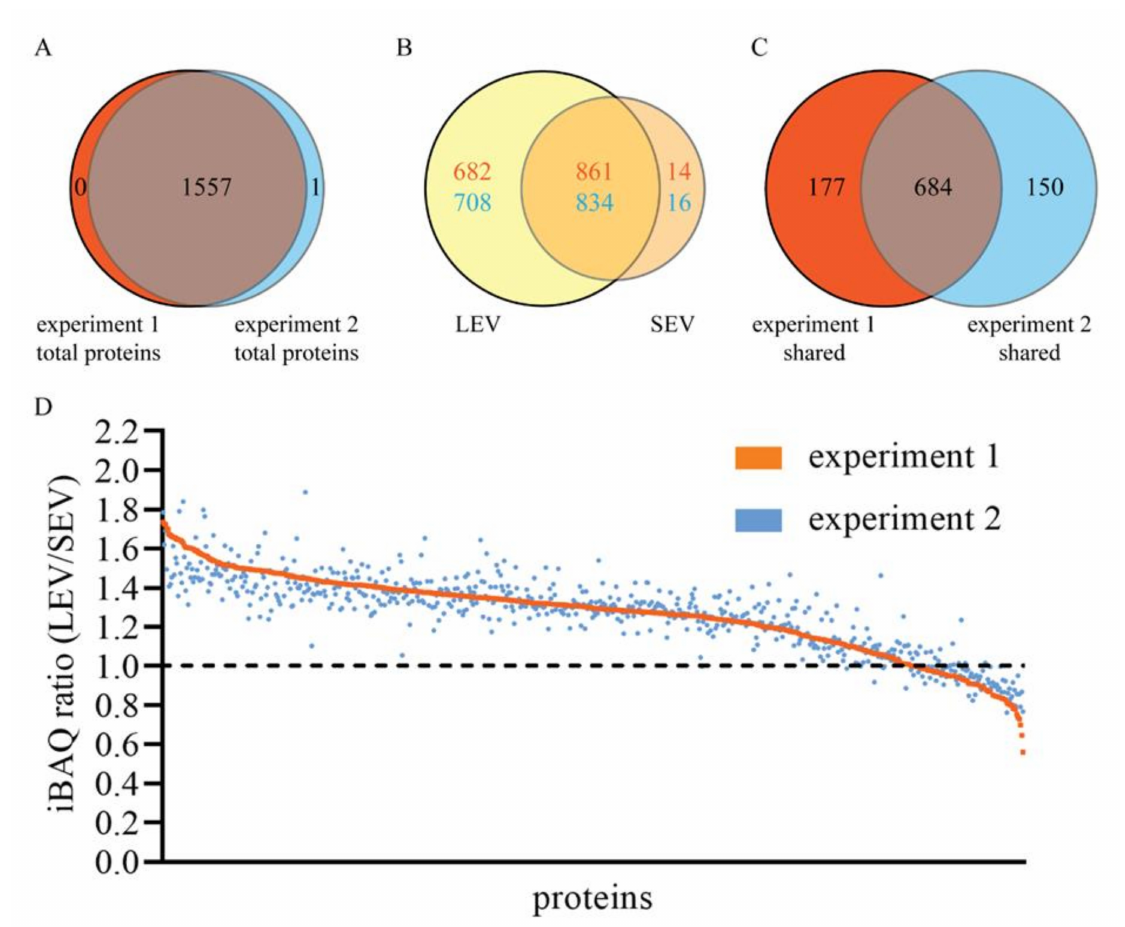
Figure 2. MS / MS identification and relative quantification of proteins in LEV and SEV. ( A ) Venn diagram indicating the total number and overlap of proteins in LEV and SEV detected in experiment 1 (red) and experiment 2 (blue). ( B ) Venn diagram comparing of proteins detected in LEV (yellow) and SEV (beige) in experiment 1 (red numbers) and experiment 2 (blue numbers). ( C ) Venn diagram comparing proteins that are shared by LEV and SEV in experiment 1 (red) with those in experiment 2 (blue). ( D ) iBAQ ratios (LEV / SEV) for all 684 proteins that shared within both experiment 1 and experiment 2, as indicated in C. Proteins are plotted on x-axes by decreasing iBAQ ratio in experiment 1 (red line). The same proteins are plotted in the same order along the x-axes for experiment 2 (blue